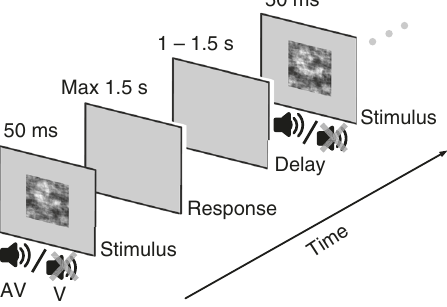
Fig. 1 Experimental paradigm. Schematic representation of the task design illustrating the order of presented events on the testing day. Participants had to categorize noisy representations of faces and cars. A brief stimulus, which was either an image (V) or a congruent image and sound (AV), was presented for 50 ms and followed by a delay period of up to 1500 ms during which participants were required to indicate their decision with a button press. Their response was followed by an intertrial interval (blank gray screen), jittered between 1000 and 1500 ms in duration, before the next stimulus was